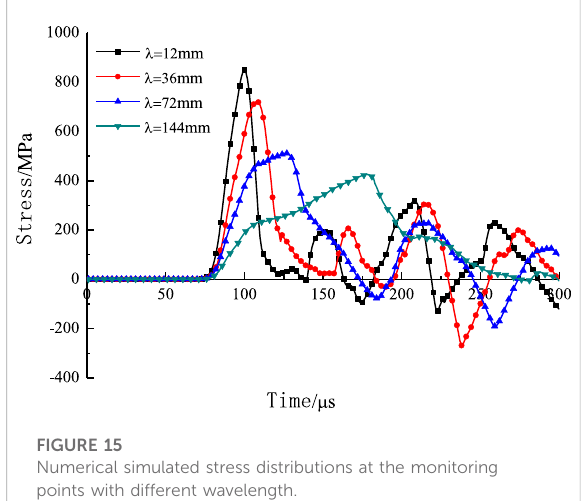
FIGURE 15 Numerical simulated stress distributions at the monitoring points with different